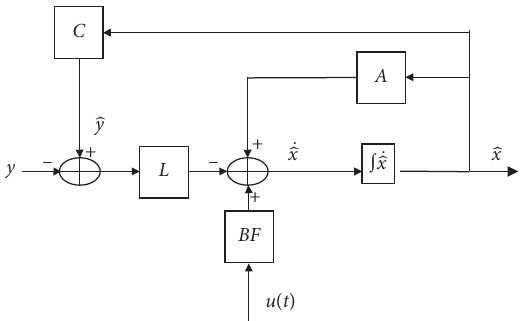
Figure 4: The state observer